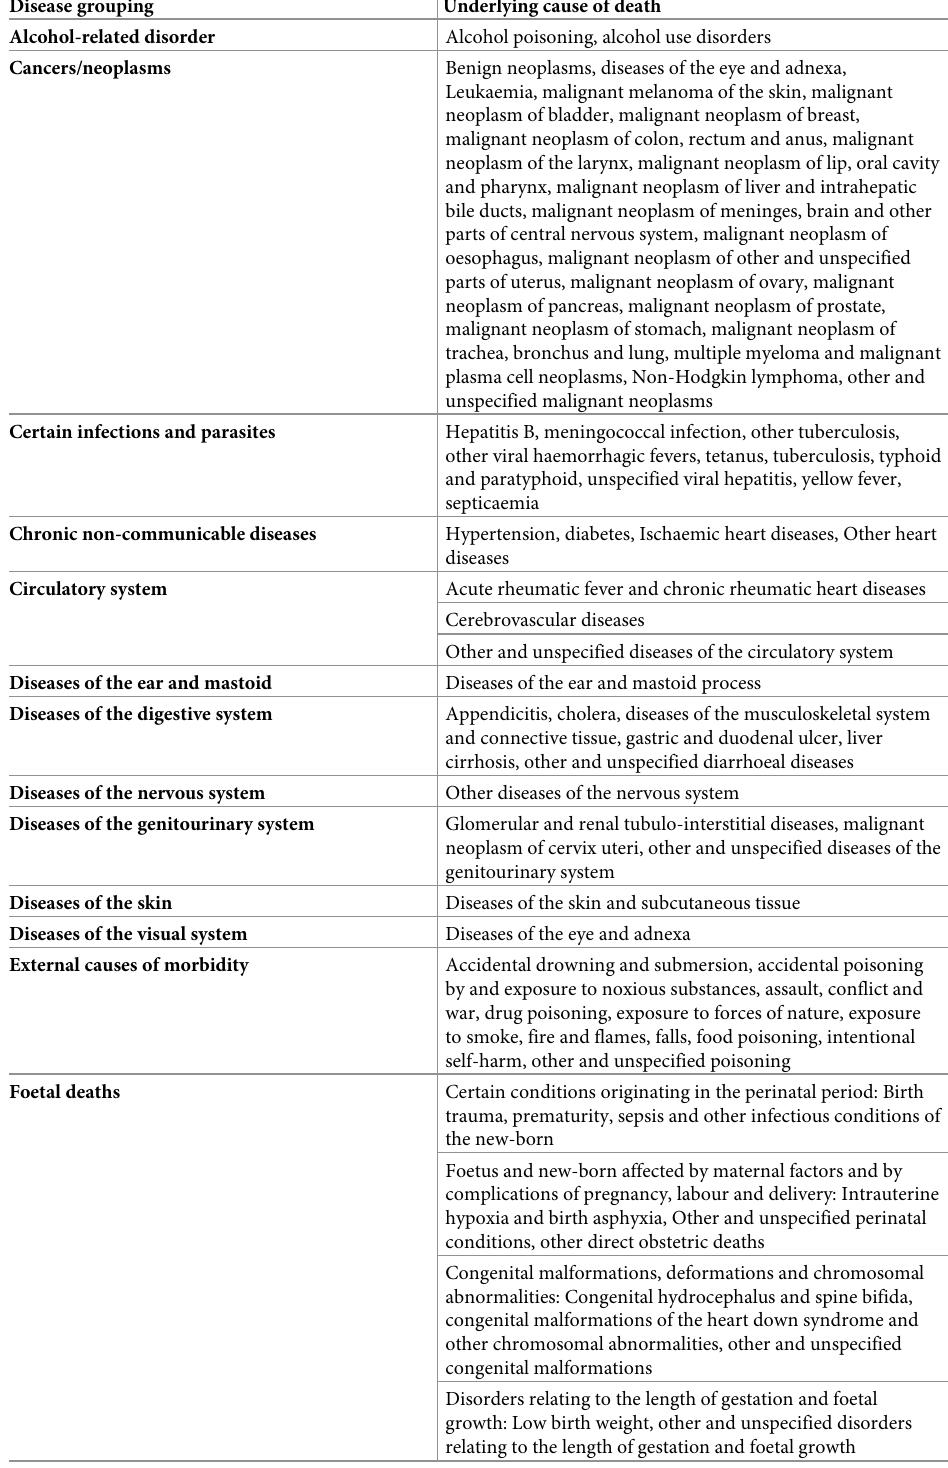
Table 1. Disease groupings for the cause of death analysis using the World Health Organisation’s ICD-11 for mortality and morbidity